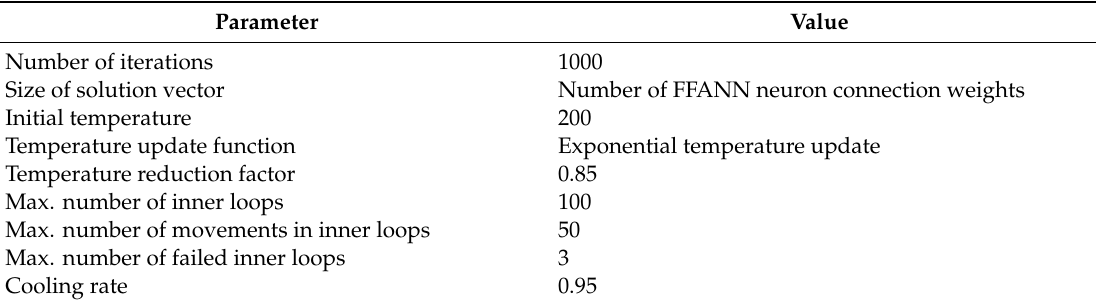
Table 2. Parameters of the SA